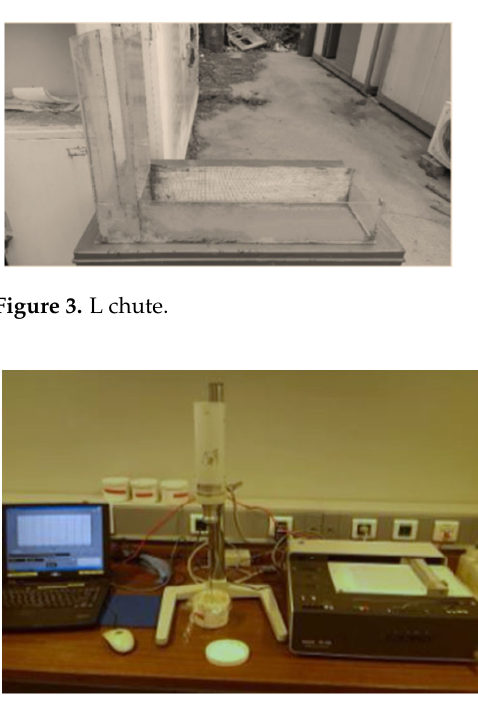
Figure 4. Rheometer detection.